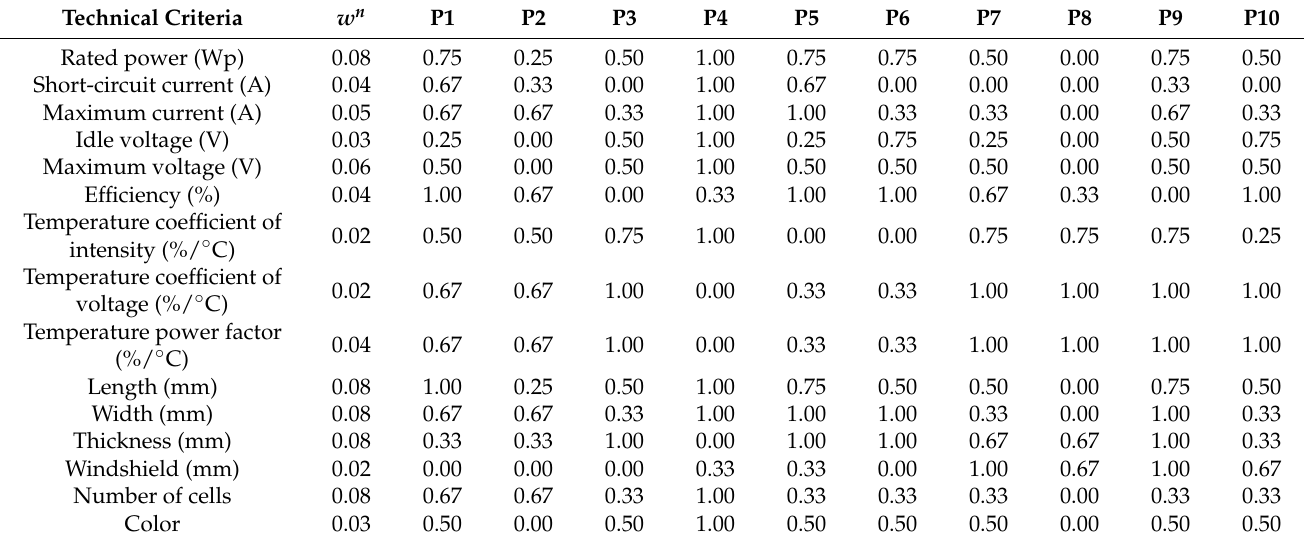
Table 8. Weights of criteria and normalized values of photovoltaic panels quality.